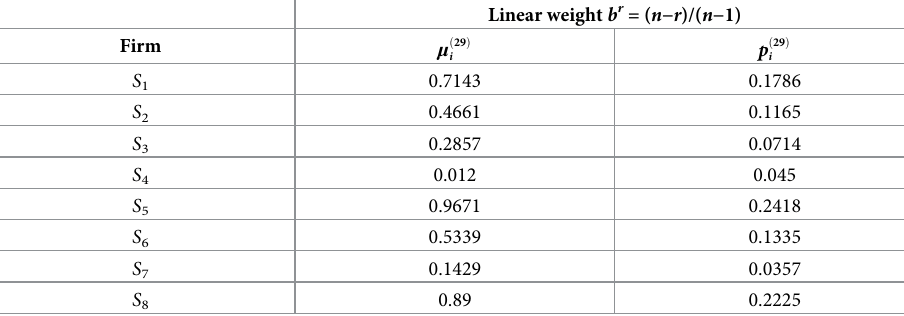
Table 5. Weights of S 1 , S 2 , ��� , S 8 under the linear weighting